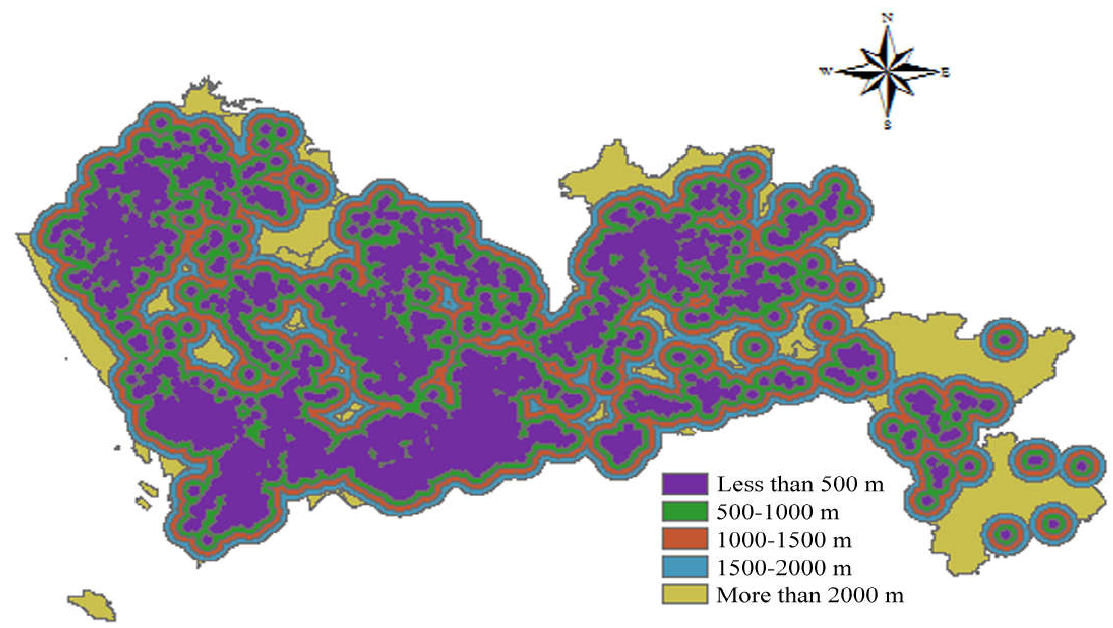
Figure 12. Map of distance to urban settlements.